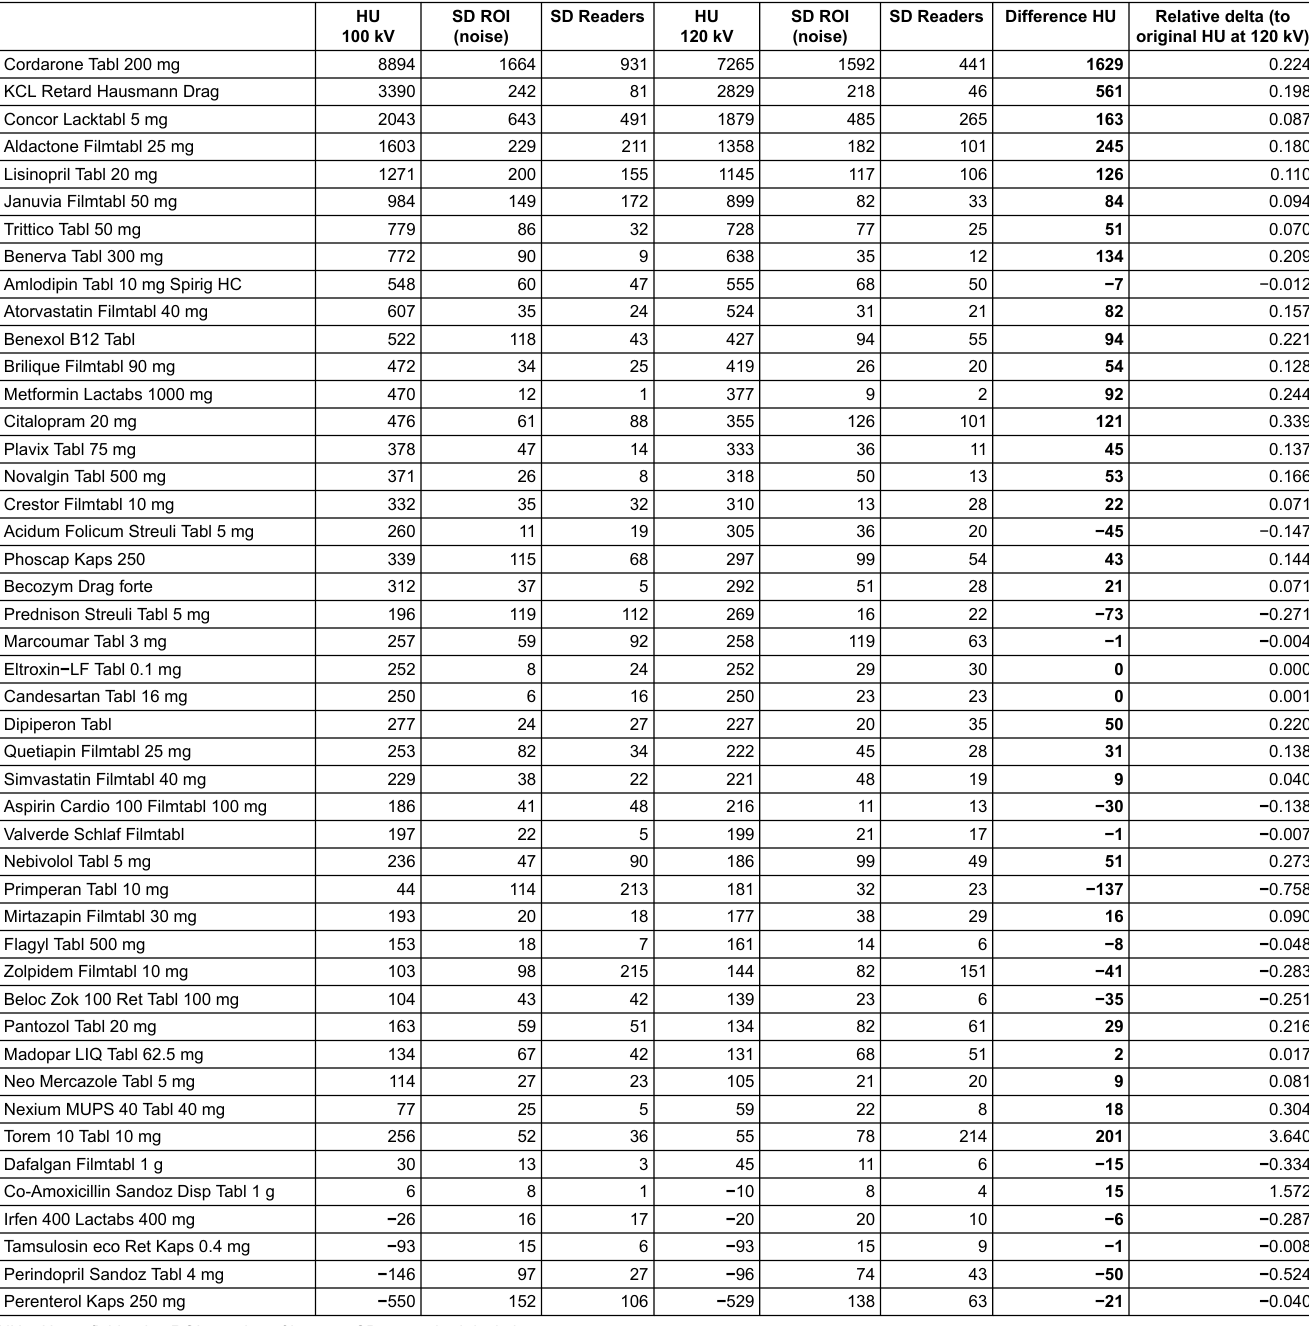
Table 1: Medicaments ranked according to density at 120 kV